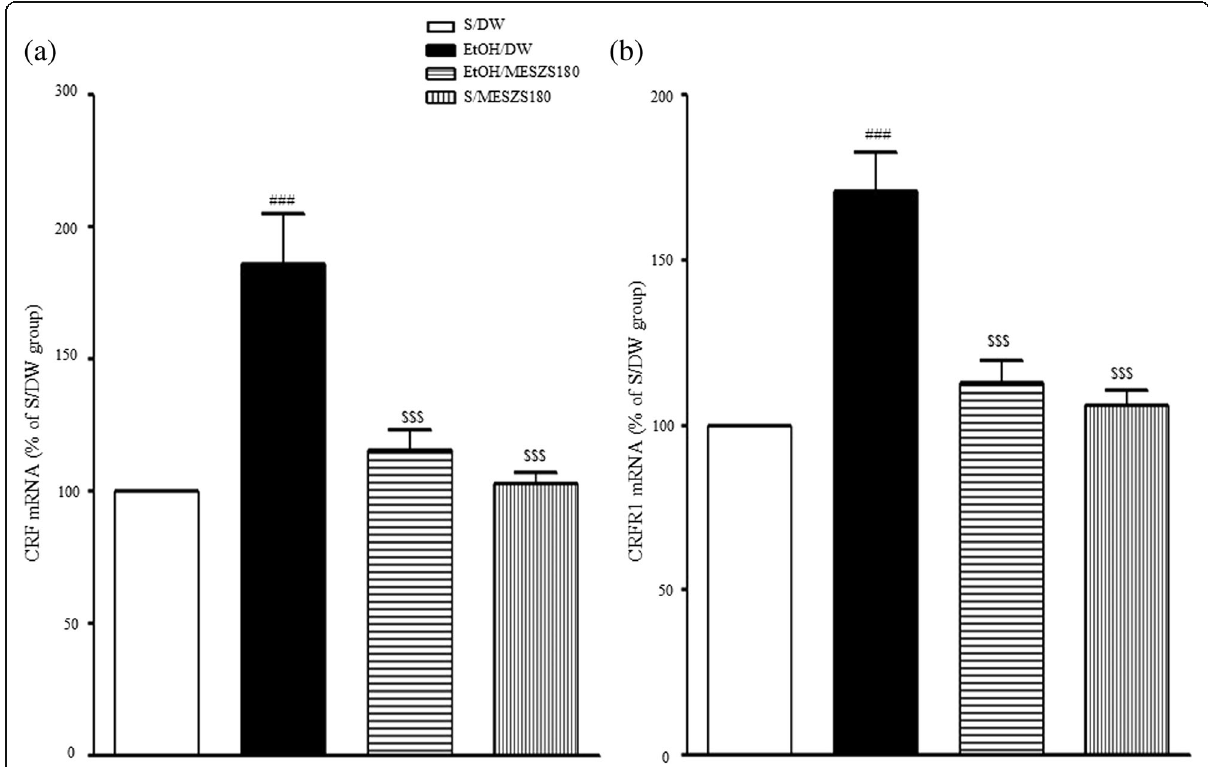
Fig. 5 Effects of MESZS on the mRNA expressions of amygdaloid ( a ) CRF and ( b ) CRFR1 during EtOHW. Immediately after the behavioral test, the mRNA levels of CRF and CRFR1 in the CeA were determined using qPCR analysis. All data are expressed as a mean ± SEM ( n = 5). S: saline, DW: distilled water, EtOH: ethanol, MESZS: methanol extract of Semen Ziziphi Spinosae , MESZS180: 180 mg/kg/d MESZS. ### p < 0.001 vs. S/DW group; $$$ p < 0.001 vs. EtOH/DW group (one-way ANOVA followed by Newman-Keuls post hoc